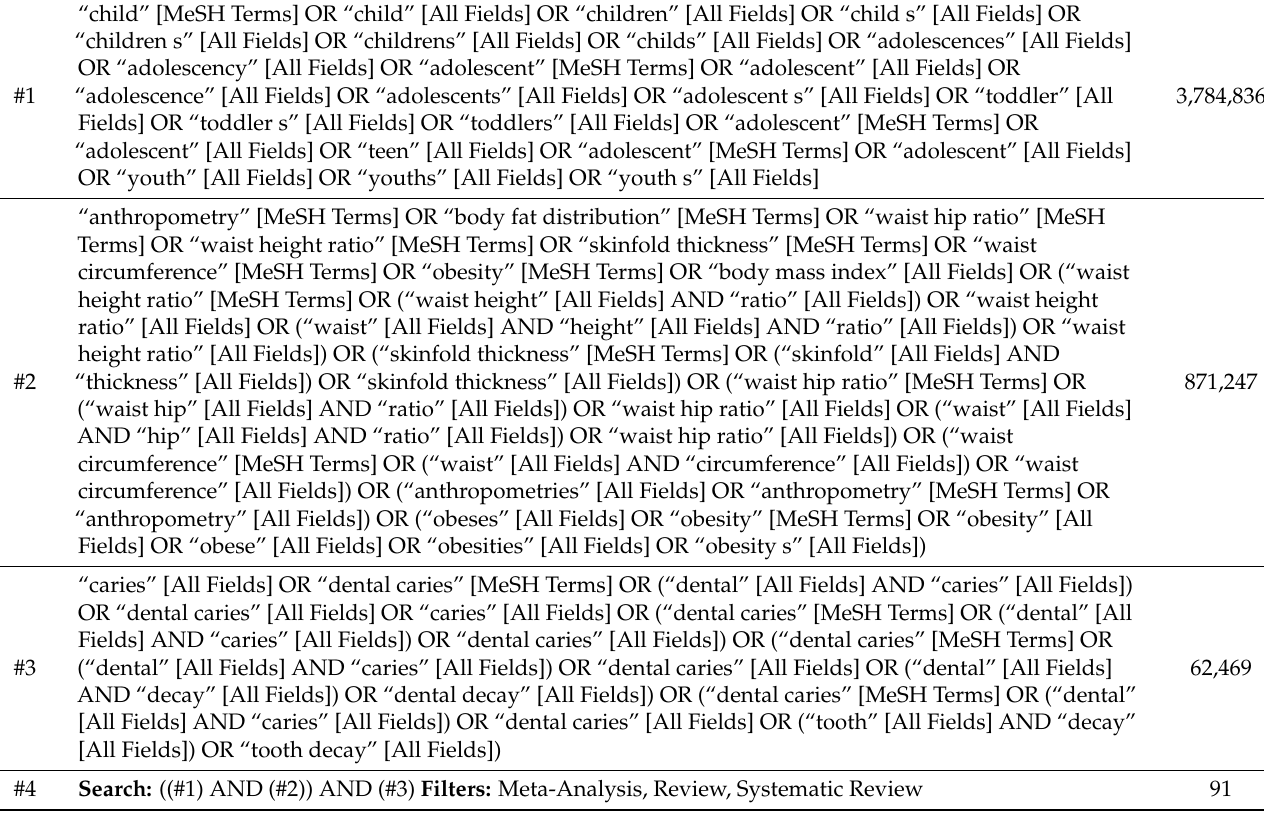
Table 1. PubMed, with its ability to explode narrower terms, built the search strategies of the three following concepts ‘children’, ‘anthropometric measurements’, and ‘caries’, then adapted it to other five databases. Search Strategy for PubMed